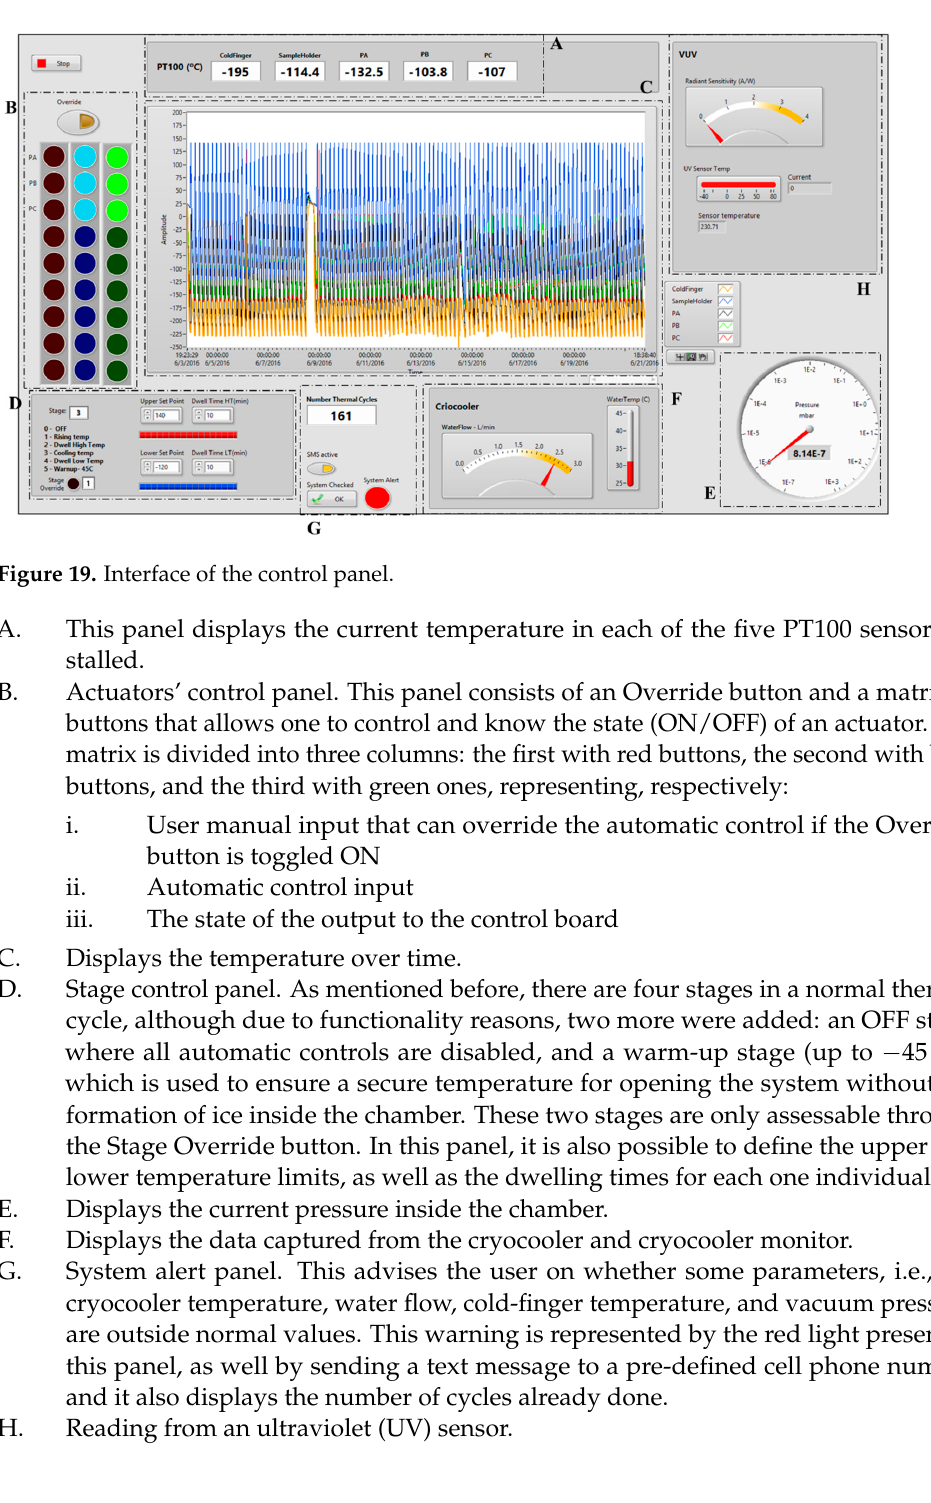
Figure 18. Cryocooler cooling capacity.